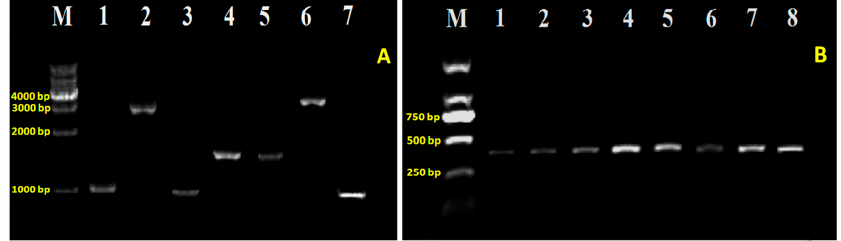
Figure 3. Validation for the complementation of T6SS mutants using specific primers of the 7 virulence-associated genes (left) and specific primer of Acidovorax avenae subsp. avenae strain RS-2 (right); ( A ) M: 1 kb DNA Ladder; 1~7: Δ pppA , Δ icmF , Δ hcp , Δ dotU , Δ impJ , Δ clpB , Δ impM ; ( B ) M: Marker 2000; 1~7: Δ pppA- comp, Δ icmF- comp, Δ hcp- com p , Δ dotU- comp, Δ impJ- comp, Δ clpB- comp, Δ impM- comp, the wild-type.